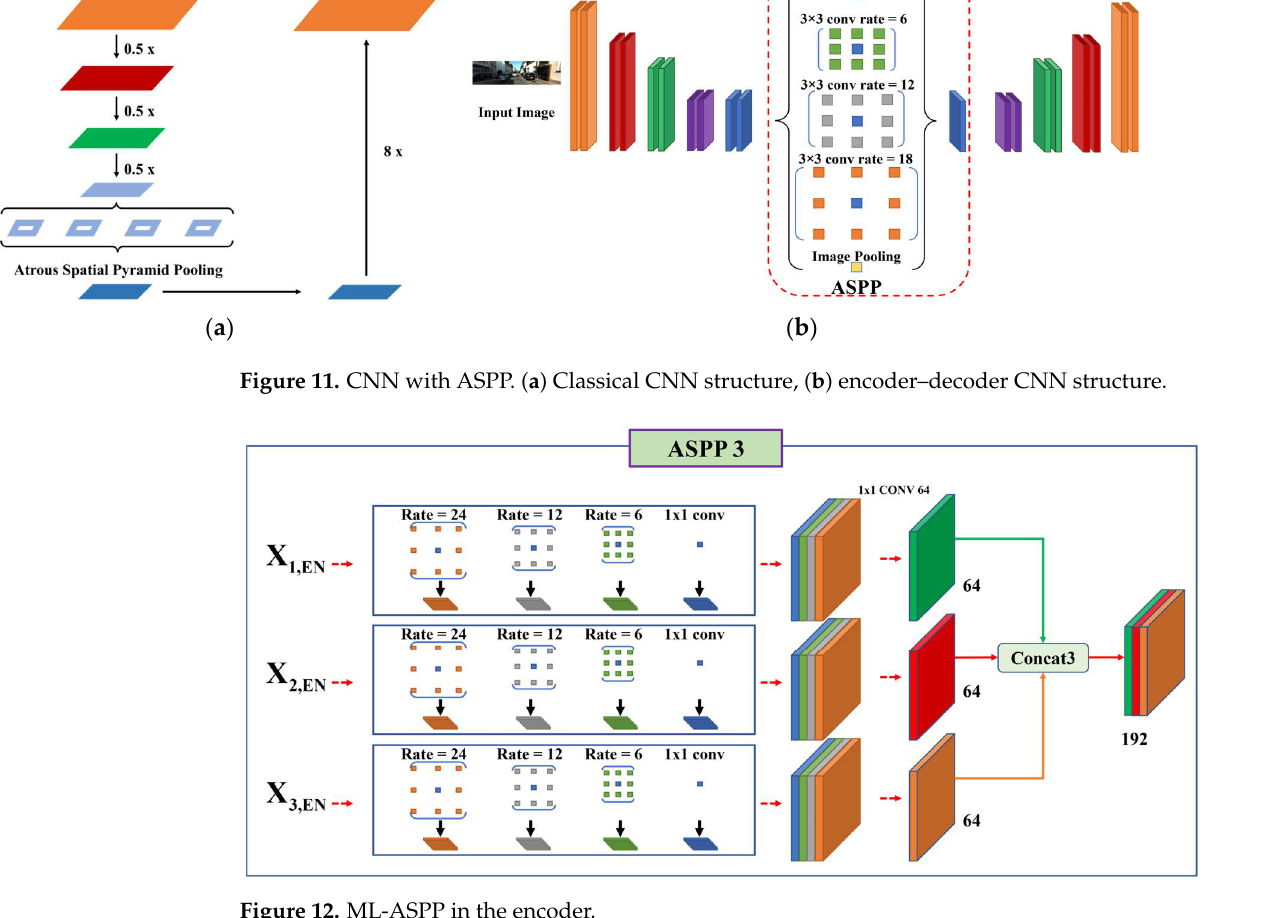
Figure 12. ML-ASPP in the